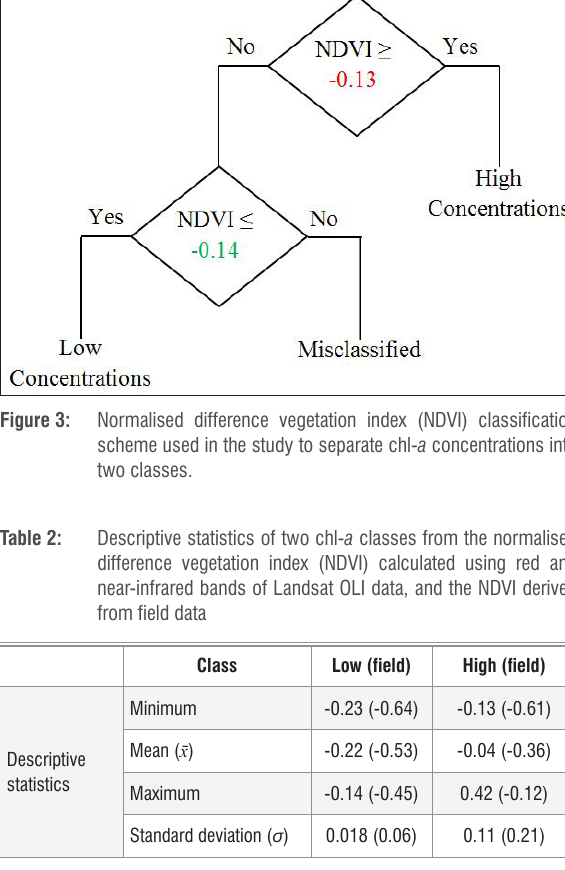
Figure 2: Typical spectral profiles of high and low classes of chl- a as observed from Landsat OLI field data of the study area.